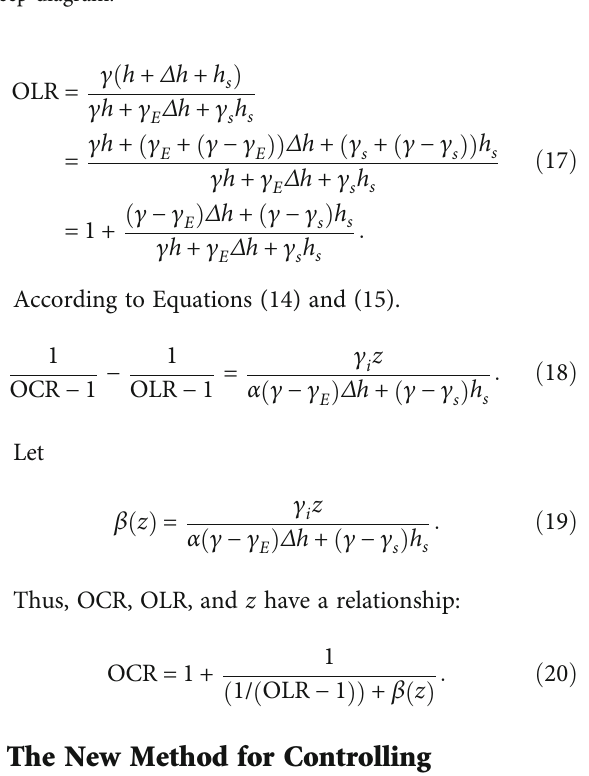
Figure 2: Bjerrum ’ s creep diagram.